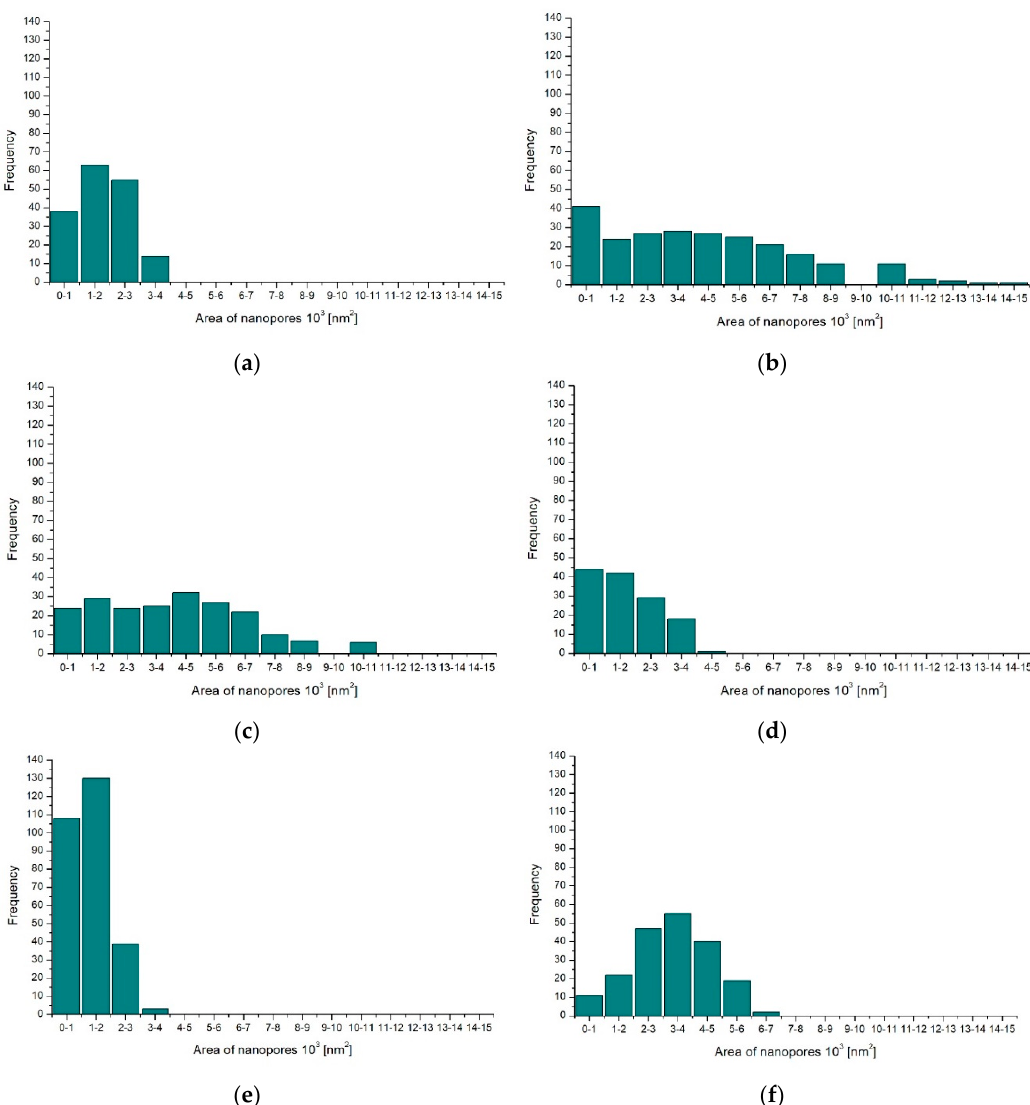
Figure 5. Histogram of prevalence of pores to their surface (designations of samples in Table 1).